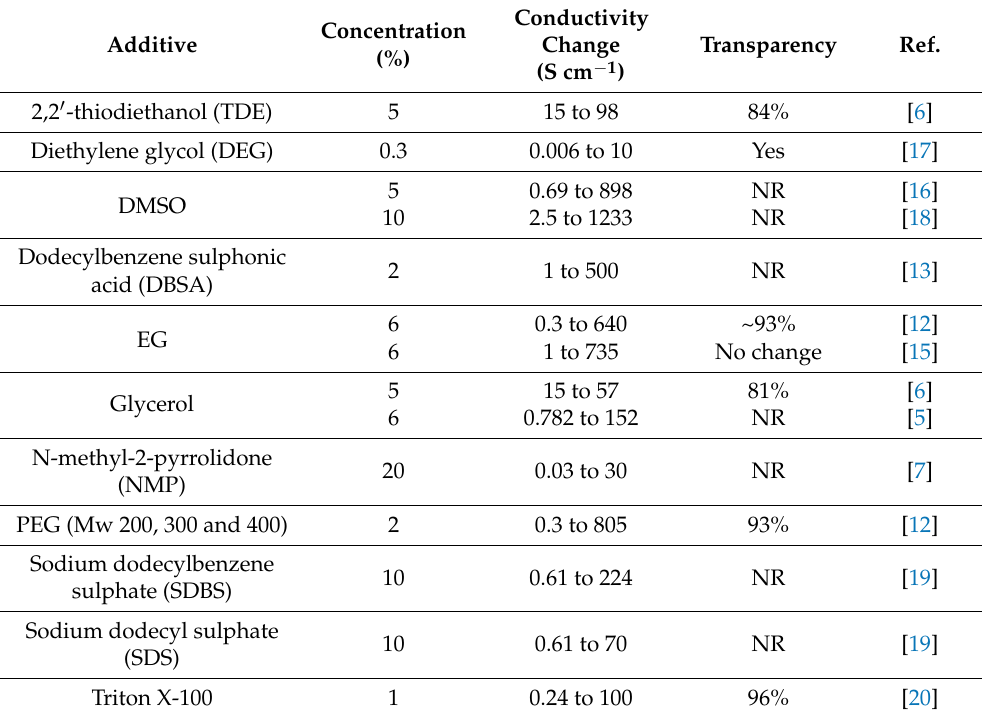
Table 1. Summary of effective secondary conductivity-enhancing agents reported to date. Additive